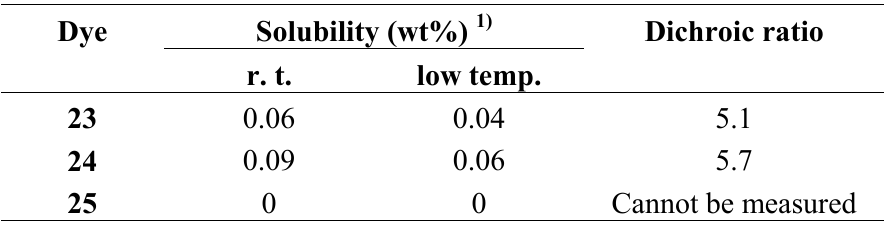
Table 8. Solubilities and dichroic ratios of cyan anthraquinone dichroic dyes with two phenylthio groups and two anilino